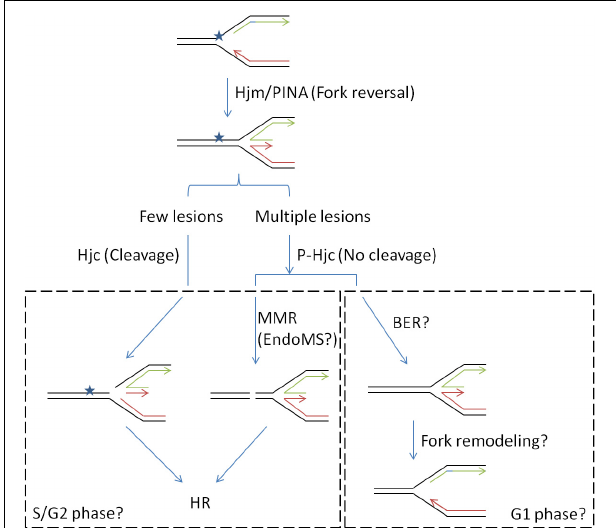
FIGURE 7 | A proposed model for the function of Hjc-S34 phosphorylation in DNA repair (stalled replication fork). DNA replication fork is usually blocked by a lesion. The stalled replication fork would be reversed to a HJ DNA by proteins such as Hjm and/or PINA (PIN domain-containing ATPase), followed by the recruitment of Hjc (Zhai et al., 2018). Phosphorylation states of Hjc might control different repair pathways: Non-phosphorylated Hjc would cleave the HJ forming a DSB which would be repaired by HR; phosphorylated Hjc at S34 would not cleave the HJ and the lesion might be repaired by mismatch repair (MMR) or base excision repair (BER). The latter may occur in the presence of high amounts of DNA lesion when treated with higher dose of DNA damaging agents. It is also possible that the choice for different pathways depended on cell cycles where S/G2 phases contain two copies of genomes for HR. MMR is probably mediated by a newly identified nuclease EndoMS, resulting in formation of a DSB repaired by HR. The replication fork might be remodeled after the lesion was removed by